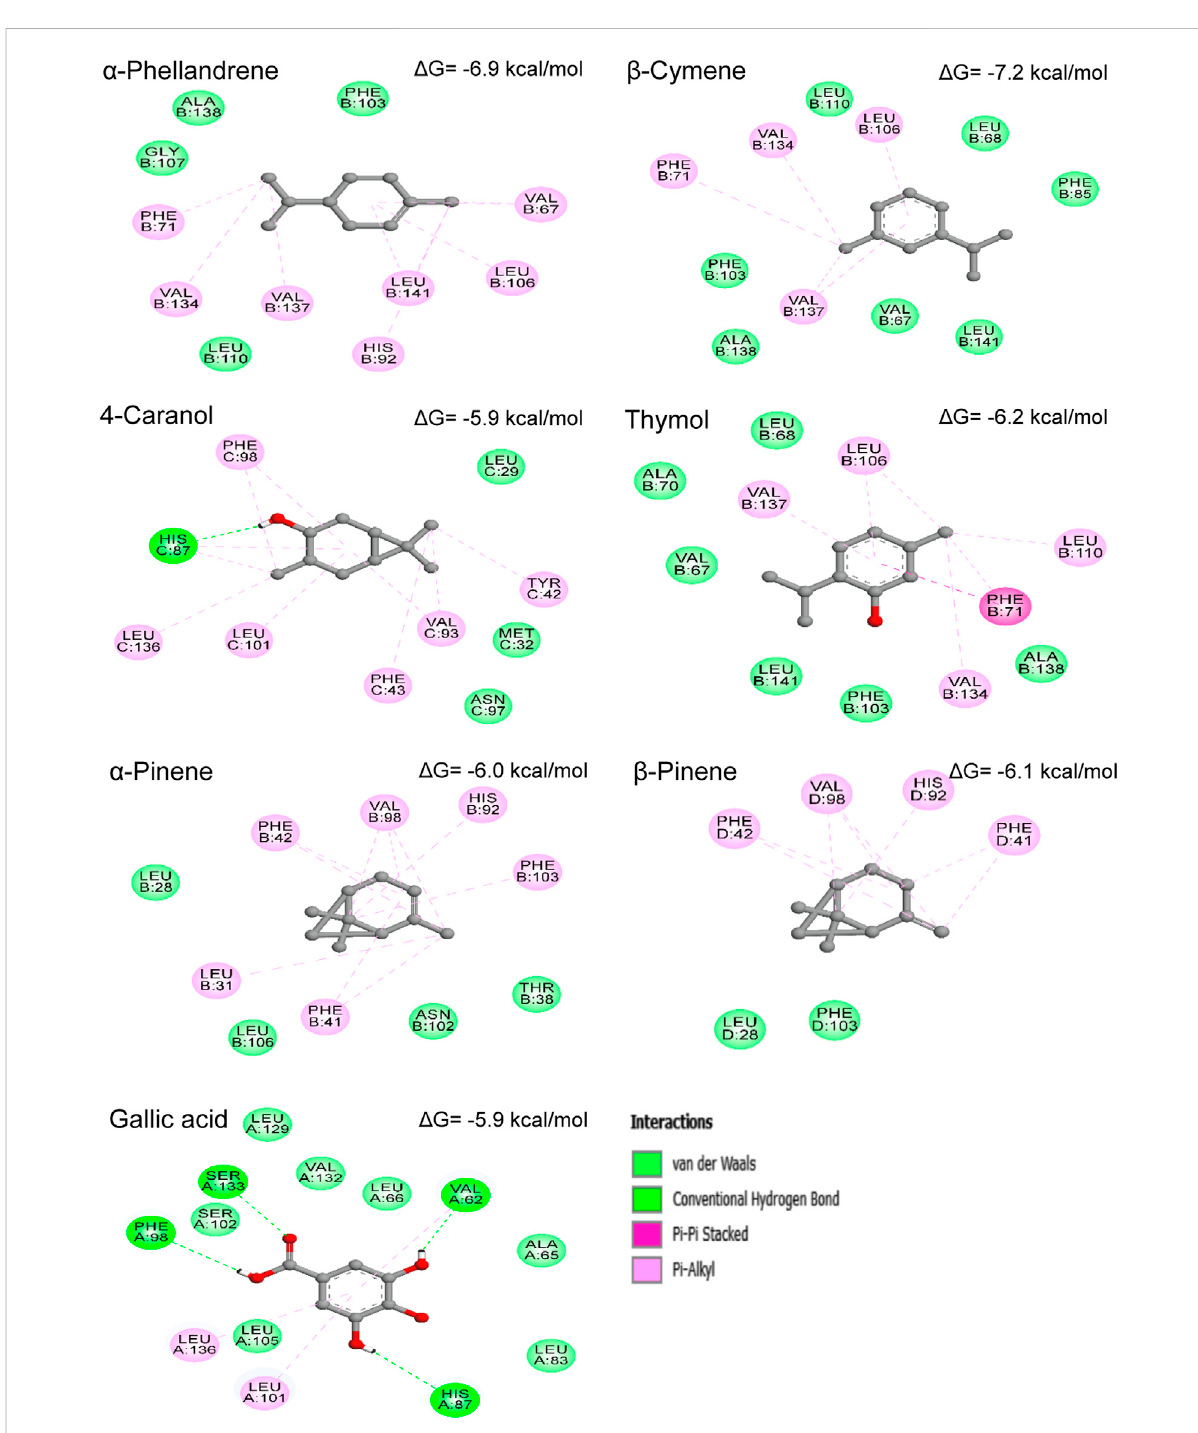
FIGURE 7 Binding energies ( Δ G) and 2D-representations of the best-docked poses of the studied ligands in the active pocked of human